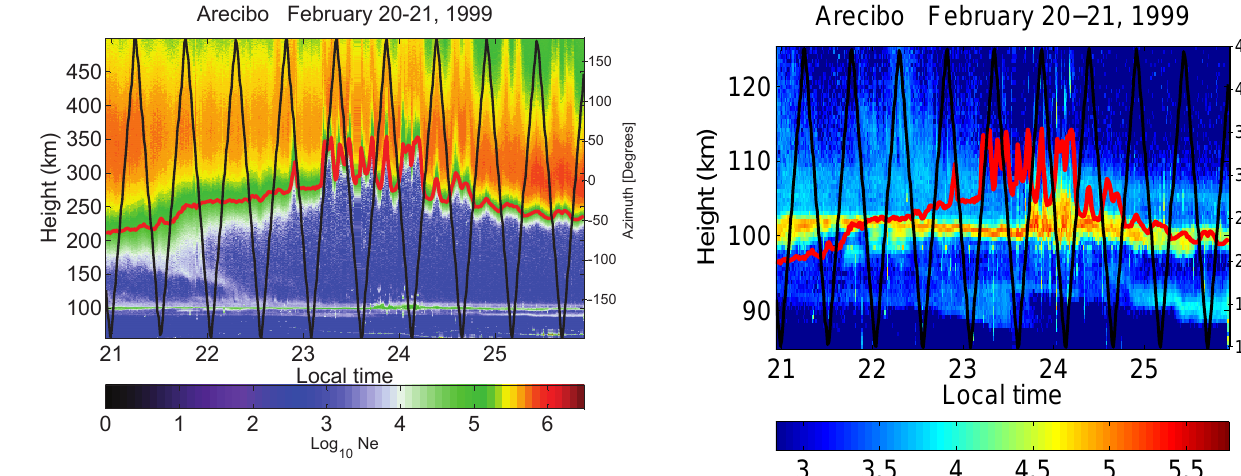
Fig. 1. Electron density through the disturbed night of 20–21 Febru- ary 1999 with the azimuth position shown by the black triangular line. (Adapted from Fig. 7 of Swartz et al. (2002).) Fig. 2. Expansion of E-region electron densities with the azimuth